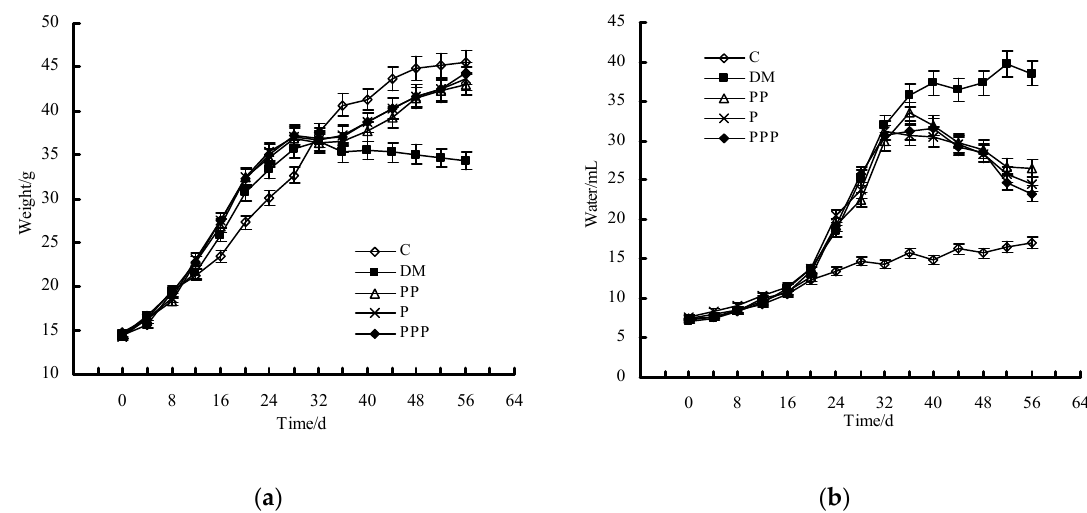
Figure 4. The effect of pumpkin polysaccharides and puerarin on the body weight and water intake of mice ( n = 10). ( a ) The effect of pumpkin polysaccharides and puerarin on the body weight. ( b ) The effect of pumpkin polysaccharides and puerarin on the water intake. C, control; DM, diabetic model; PP, pumpkin polysaccharides; P, puerarin; PPP, pumpkin polysaccharides and puerarin.